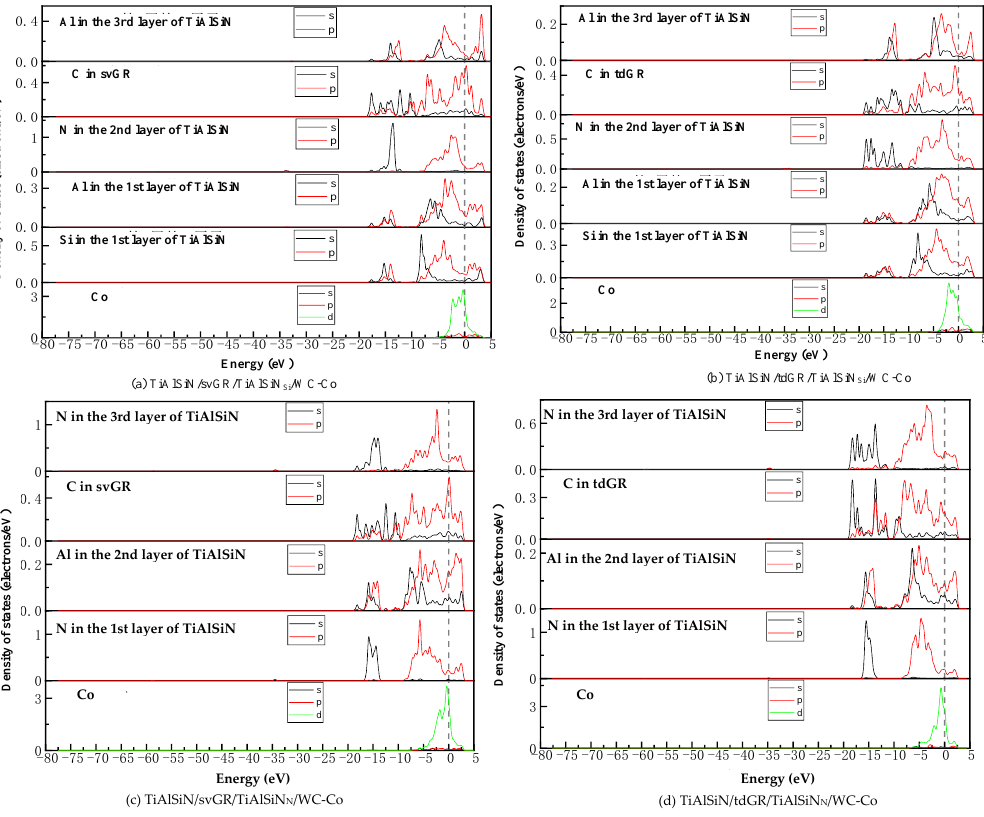
Figure 20. PDOS of the interface models with the coating doped with defective graphene.